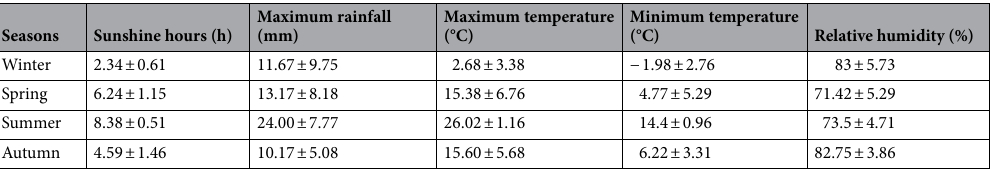
Table 1. Climatological data during the experimental period in the area where the bulls were kept (mean ± SD). The biometeorological factors, relative ambient temperature and relative humidity values were received from the meteorology station Institute of Meteorology and Water Management. Airport Meteorological Station, located at close proximity of the experimental station for estimation of temperature humidity index (THI).